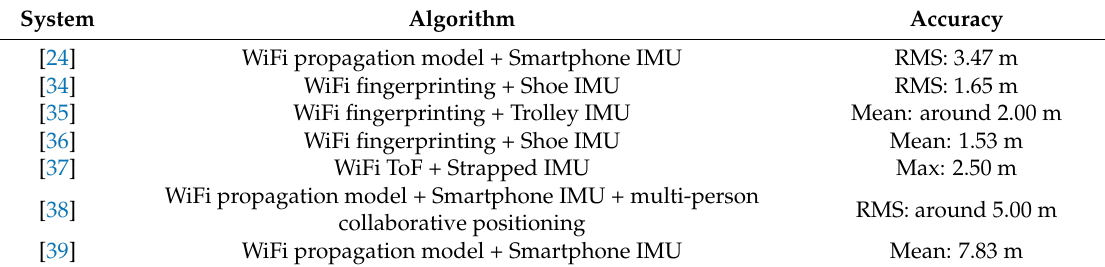
Table 1. Positioning performances from other systems. IMU– inertial measurement unit; RMS–root mean